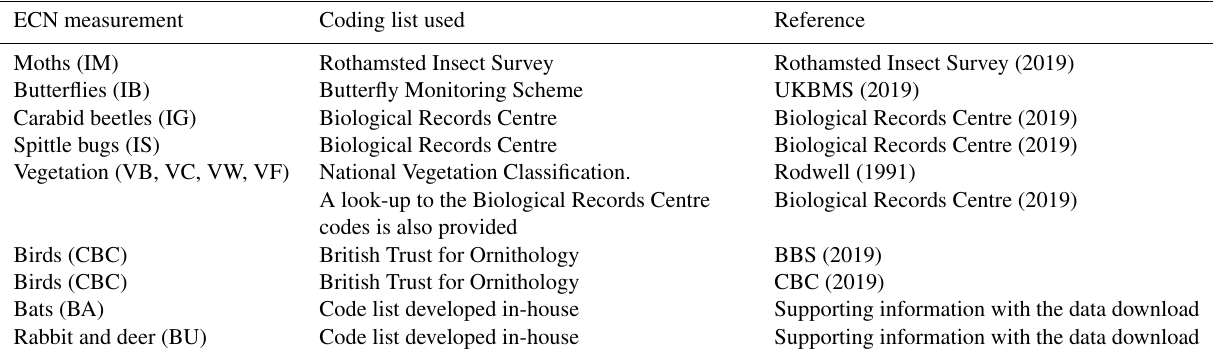
Table 8. Species coding lists. ECN